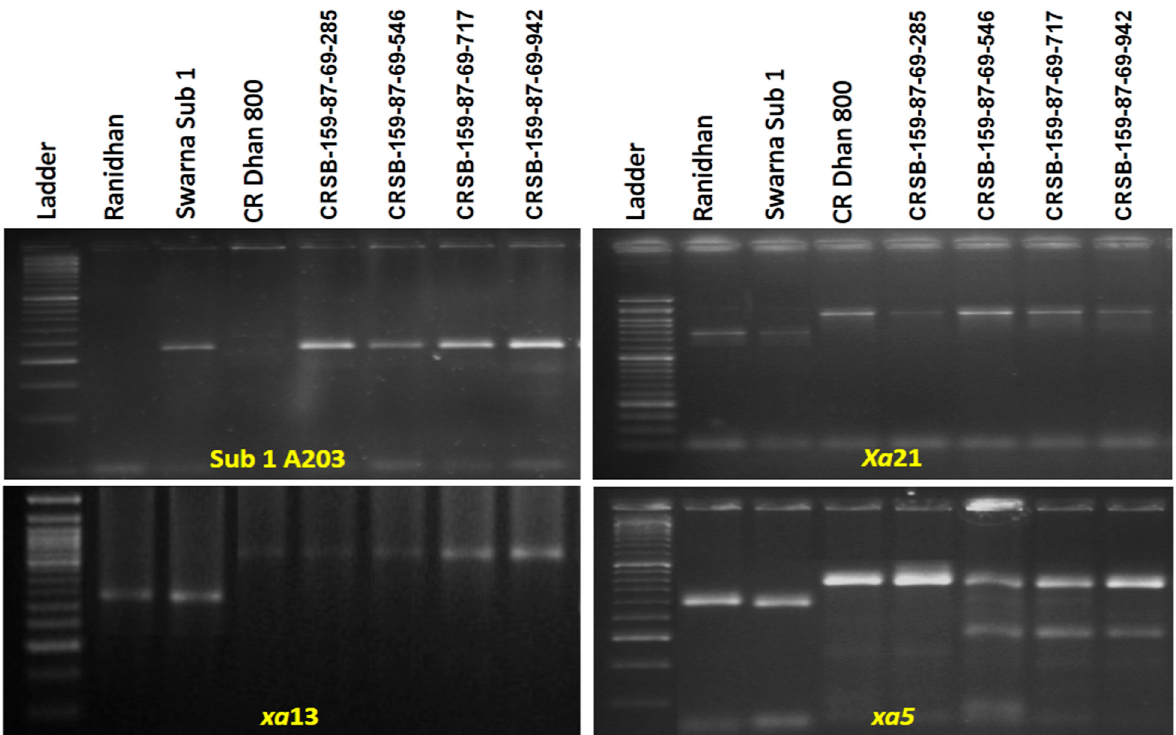
Figure 6. Representative electropherogram of BC 3 F 2 -derived lines of Ranidhan using submergence tolerance markers (Sub1 BC2 and Sub1A203 ) and markers for bacterial blight resistance genes Xa21 , xa13 , and xa5 . A 50 bp DNA ladder was used.